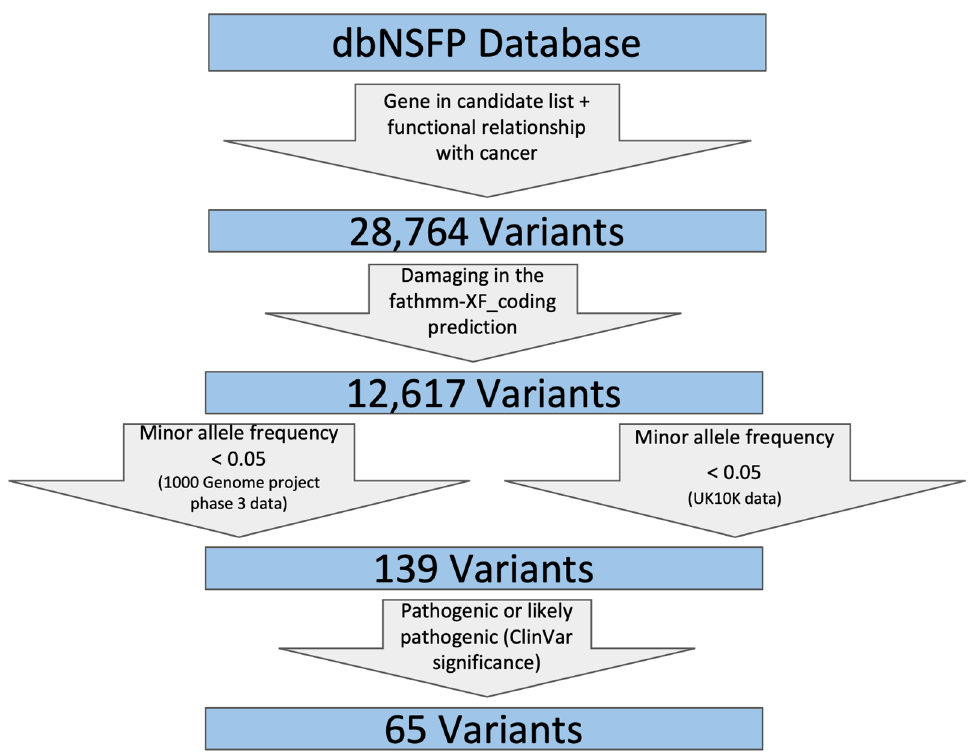
Figure 2. The workflow for filtering nonsynonymous variants using dbNSFP (database for nonsynonymous SNPs’ functional predictions).